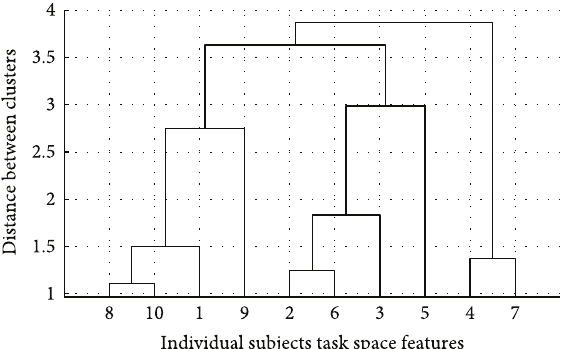
Figure 7: Taskspaceclusterseparation usinghierarchical clustering. In this case, the clusters are not well